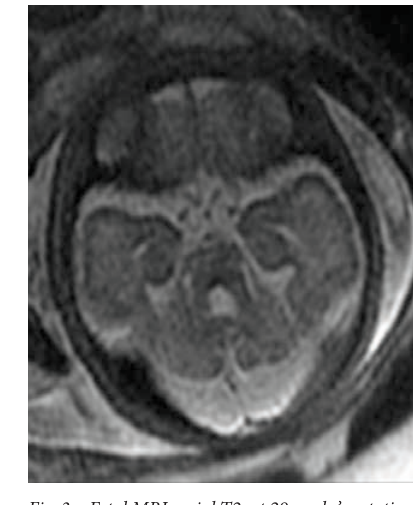
Fig. 3a. Fetal MRI, axial T2, at 29 weeks’ gestation demonstrating the molar tooth sign, which was confirmed on postnatal MRI and genetic evaluation.